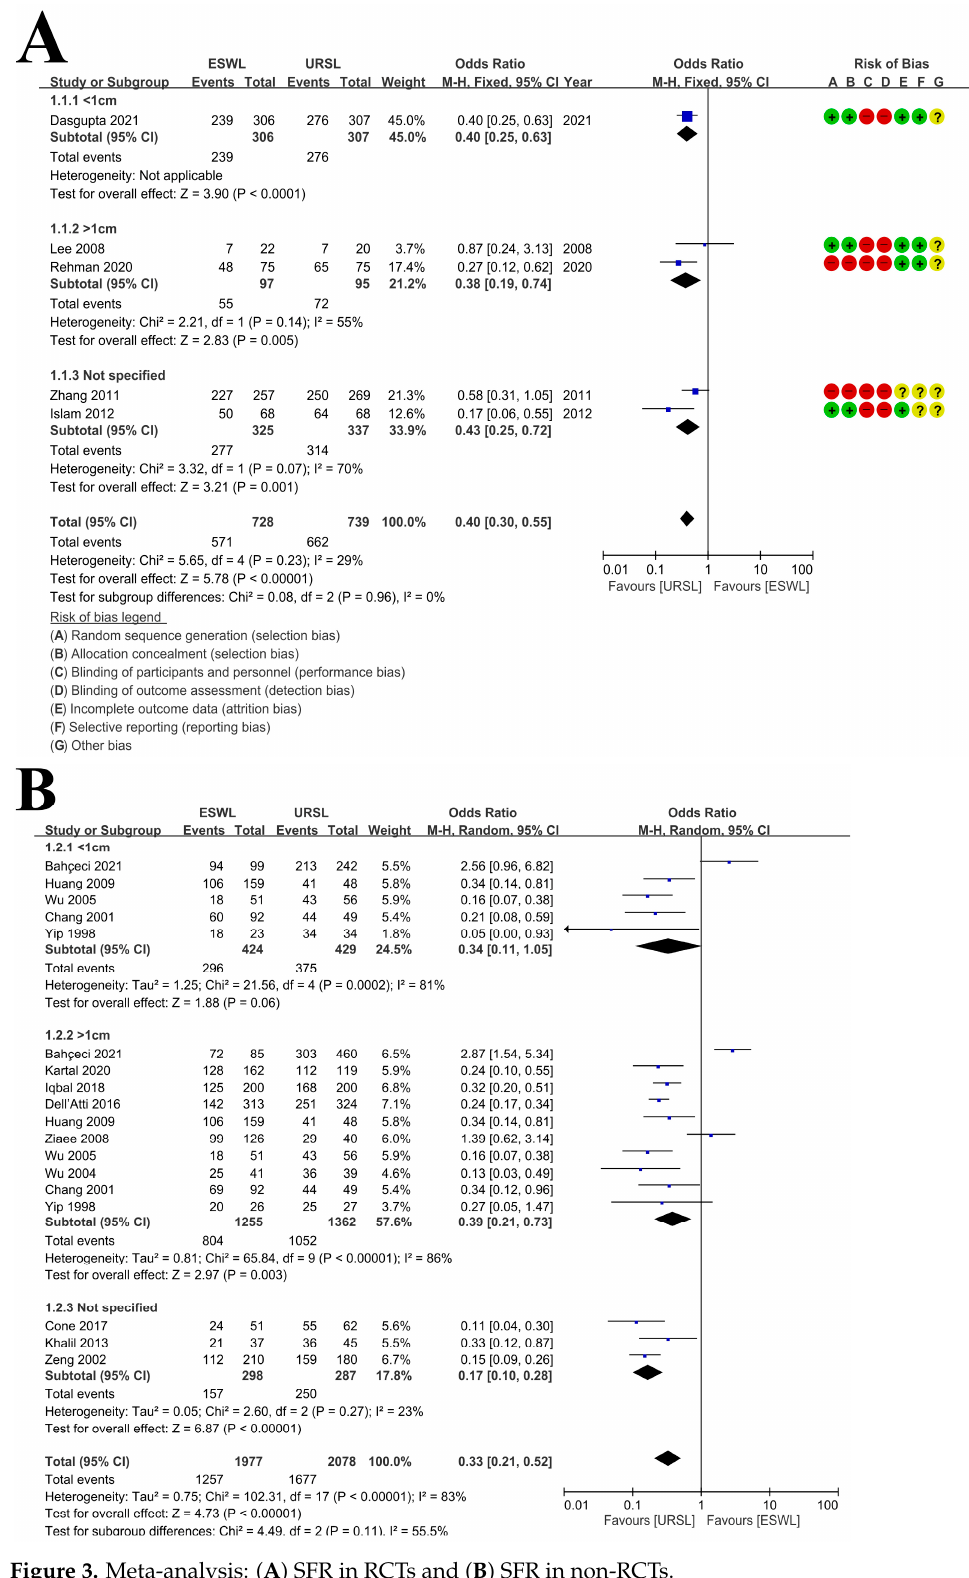
Figure 3. Meta-analysis: ( A ) SFR in RCTs and ( B ) SFR in non-RCTs.